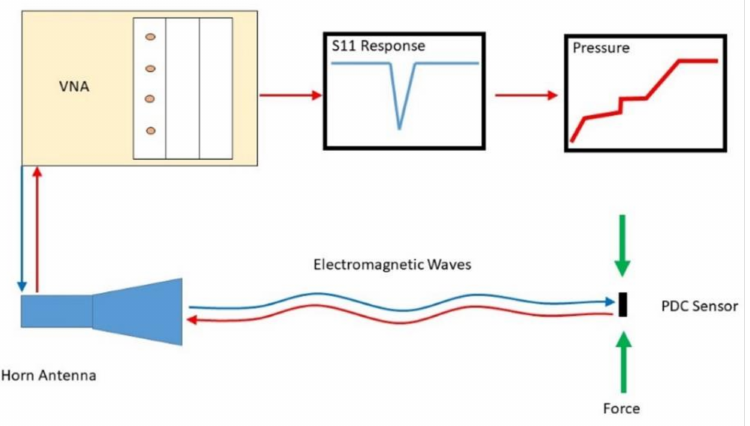
Figure 13. Wireless pressure sensing process diagram.